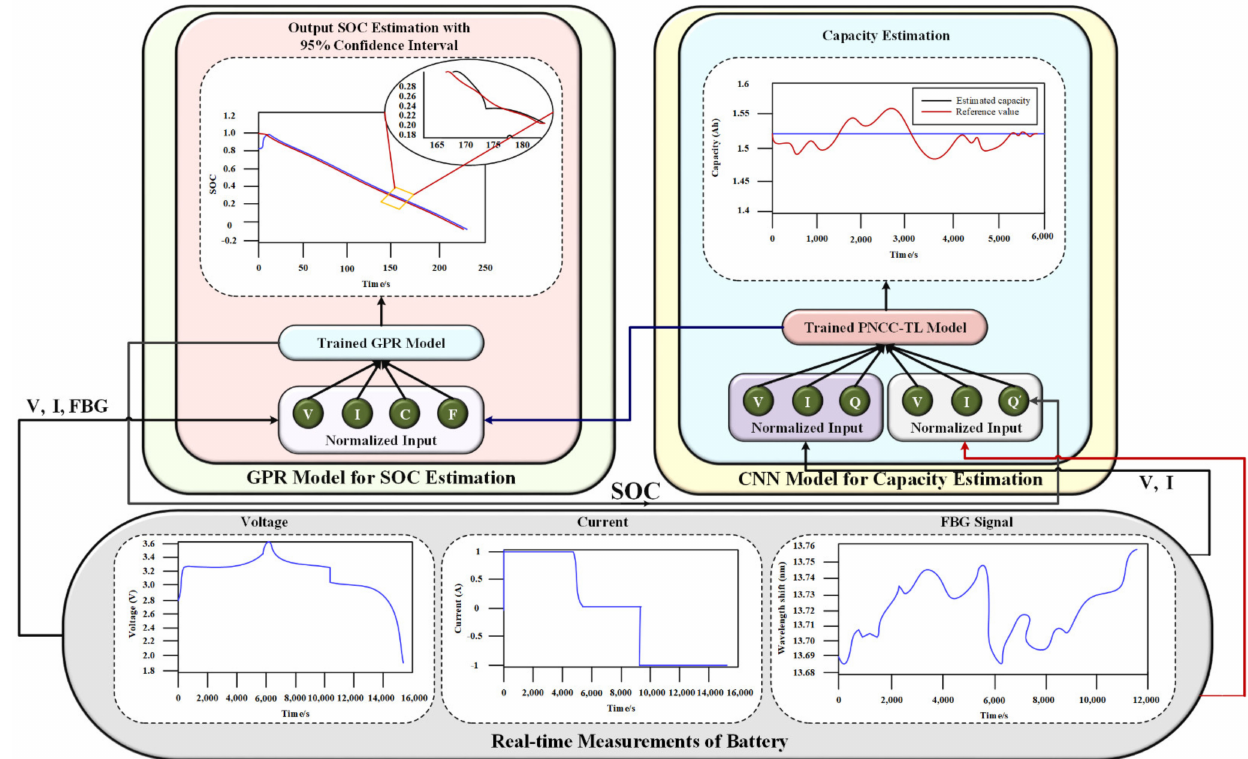
Figure 9. CNN-GPR model-based SOC estimation of lithium-ion